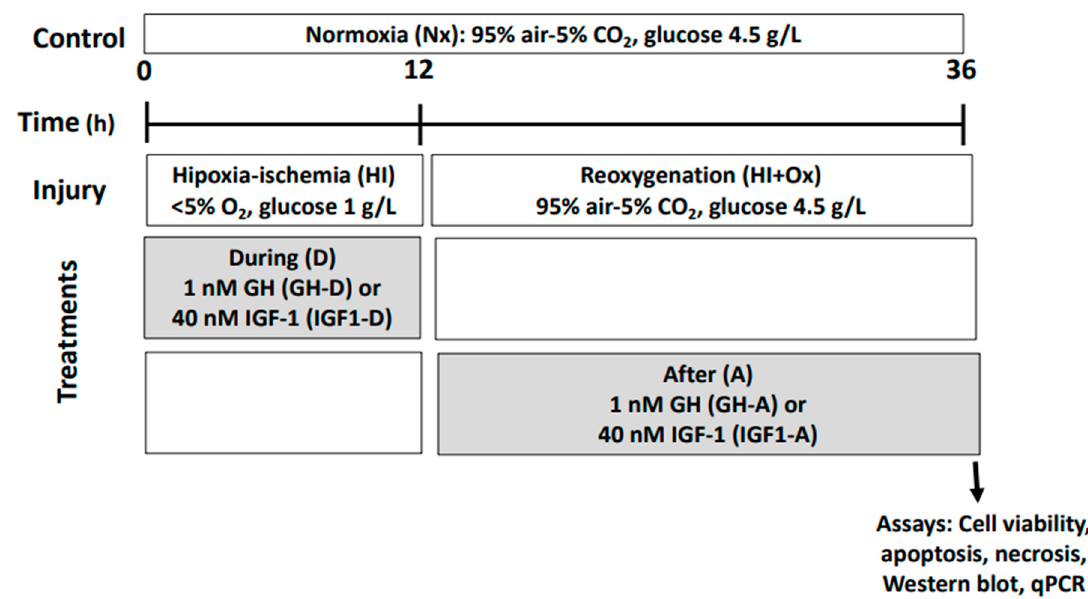
Figure 1. Schematic representation of the experimental design. Primary cerebellar cell cultures were first incubated under hypoxic-ischemic (HI; <5% O 2 , glucose 1 g/L) conditions for 12 h, and then incubated under normal oxygenation and glucose conditions for another 24 h (reoxygenation, HI + Ox). Growth hormone (GH) and insulin-like growth factor 1 (IGF-1) treatments were added either during HI conditions or after in HI + Ox (D denotes during, A denotes after); their effect on cell viability (MTT assay), apoptosis (Caspase-3 activity assay), necrosis (LDH activity), immunoreactivity of several markers (i.e., NeuN, DCX, pAkt, pERK1/2, Bcl-2 by Western blot), and expression of GH, GHR, IGF-1 and IGF-1R mRNAs by qPCR was evaluated.